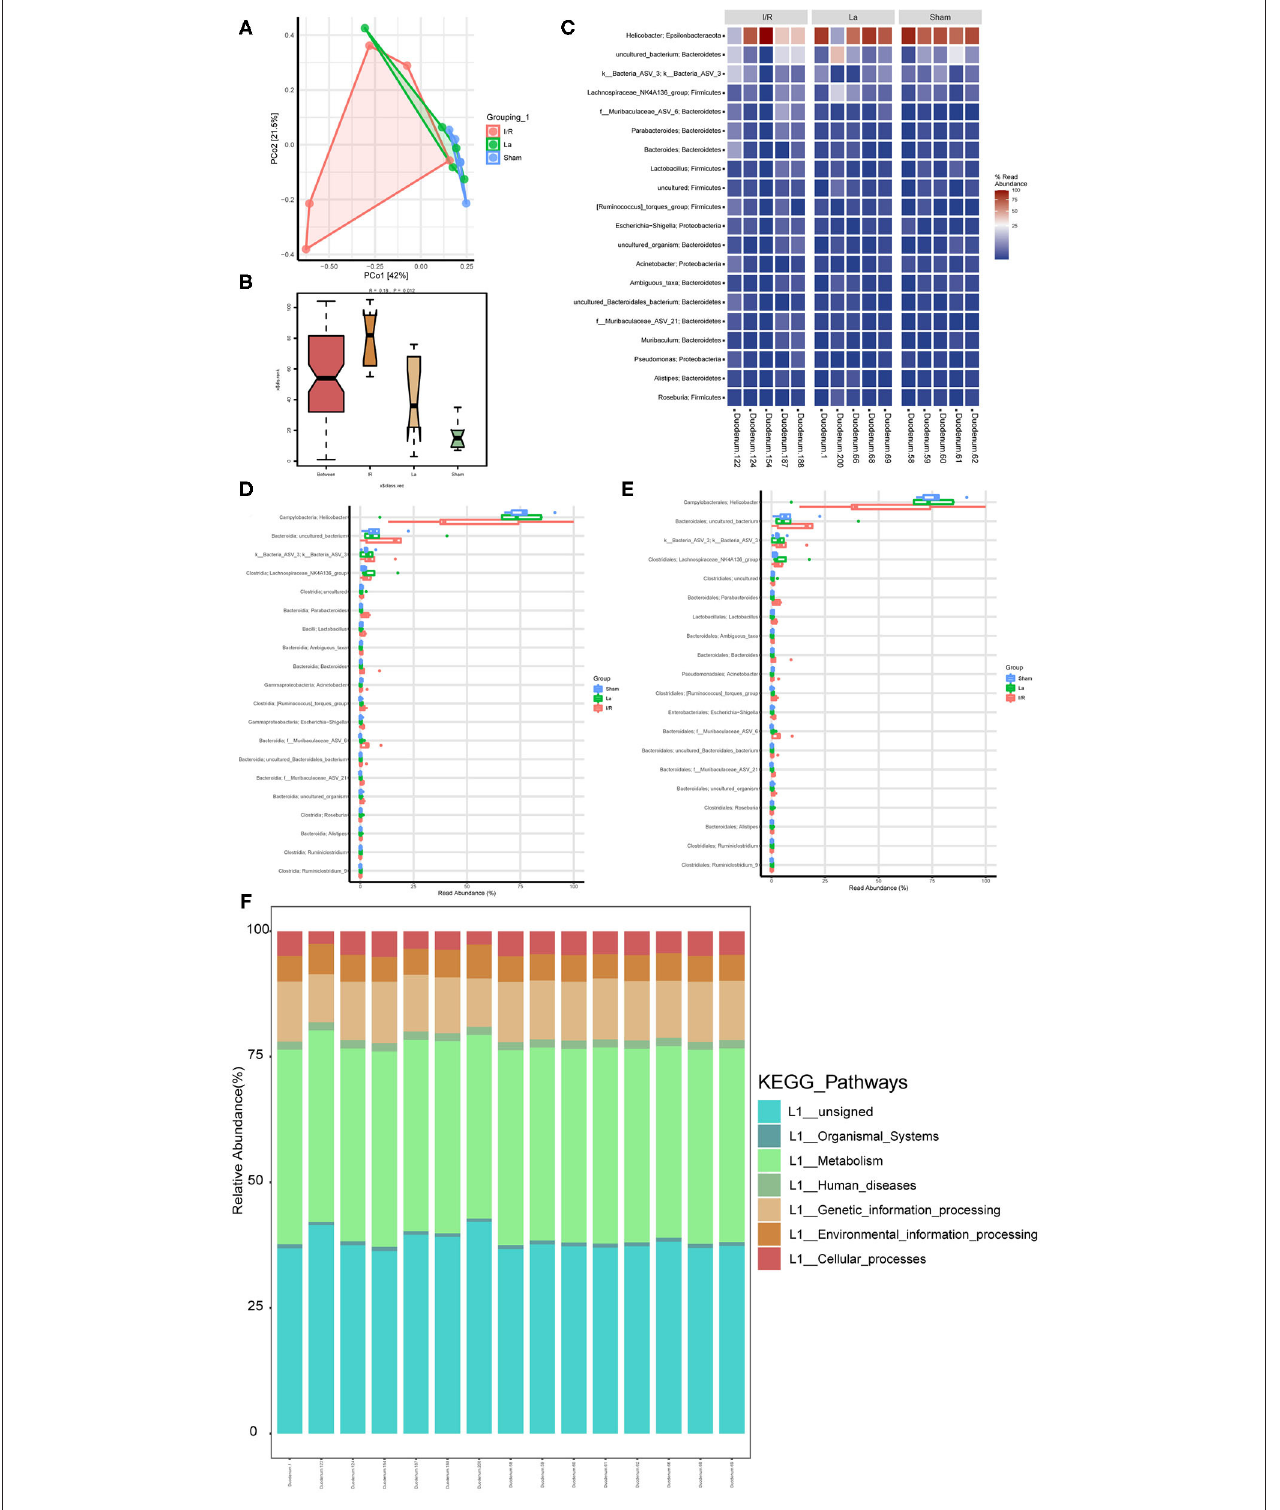
FIGURE 5 | Gut microbiota composition profiles in mice with renal ischemia–reperfusion injury (IRI). (A) Scatter plots of principal coordinates analysis (PCoA) for gut microbiota composition to show β -diversity in Sham, ischemia/reperfusion (I/R), and La group. (B) Anosim analysis to evaluate the overall similarity among Sham,